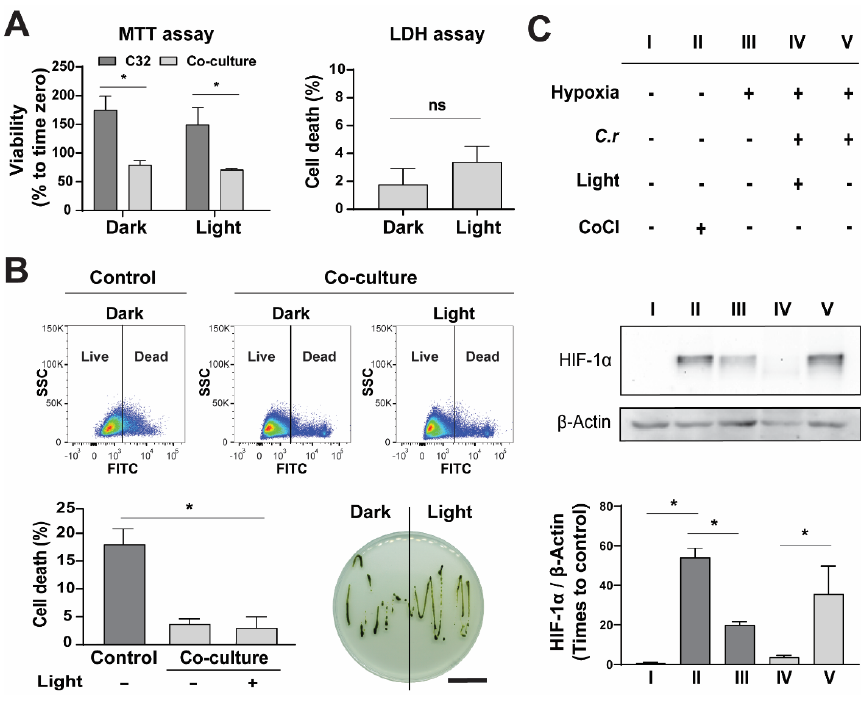
Figure 4. Effect of illumination in co-cultures of C. reinhardtii and C32 tumor cells. Cells were